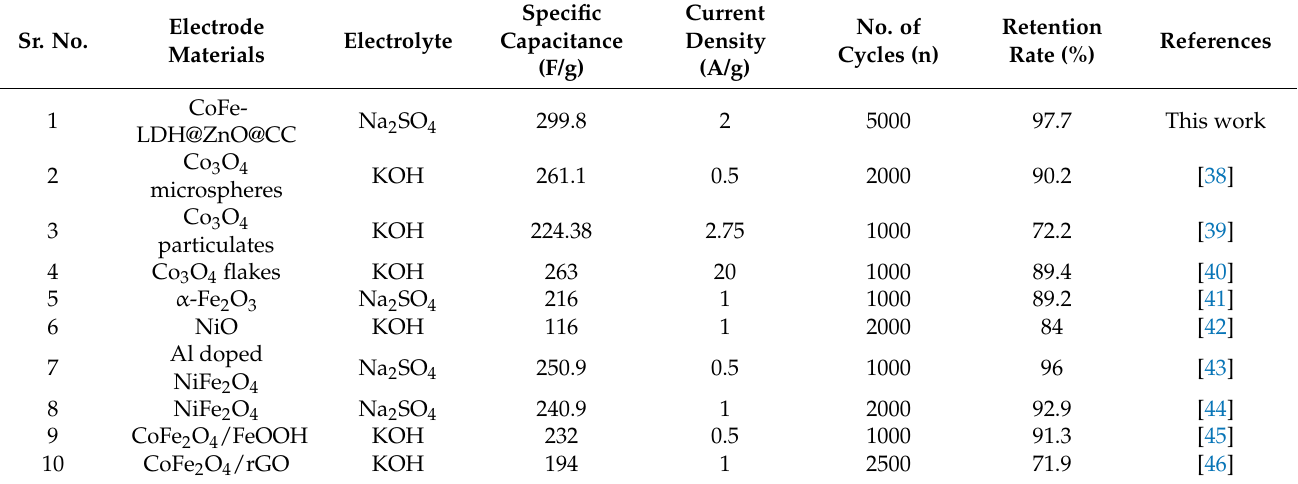
Table 1. The comparison of ZnO@CC and CoFe-LDH@ZnO@CC with previously related work.